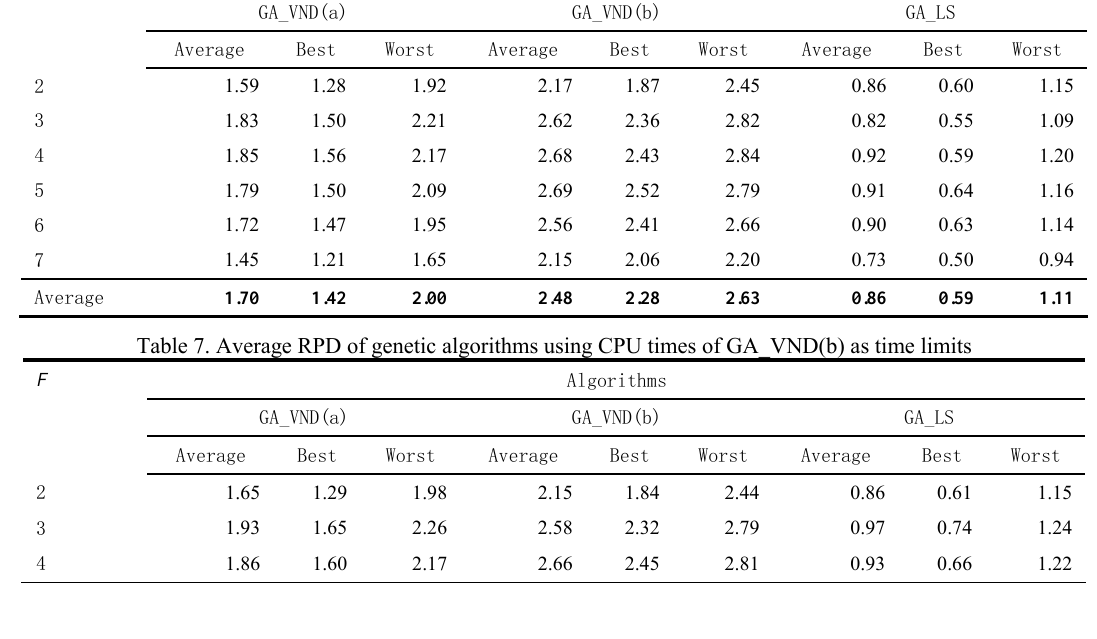
Table 6. Average RPD of genetic algorithms using CPU times of GA_VND(a) as time limits F Algorithms